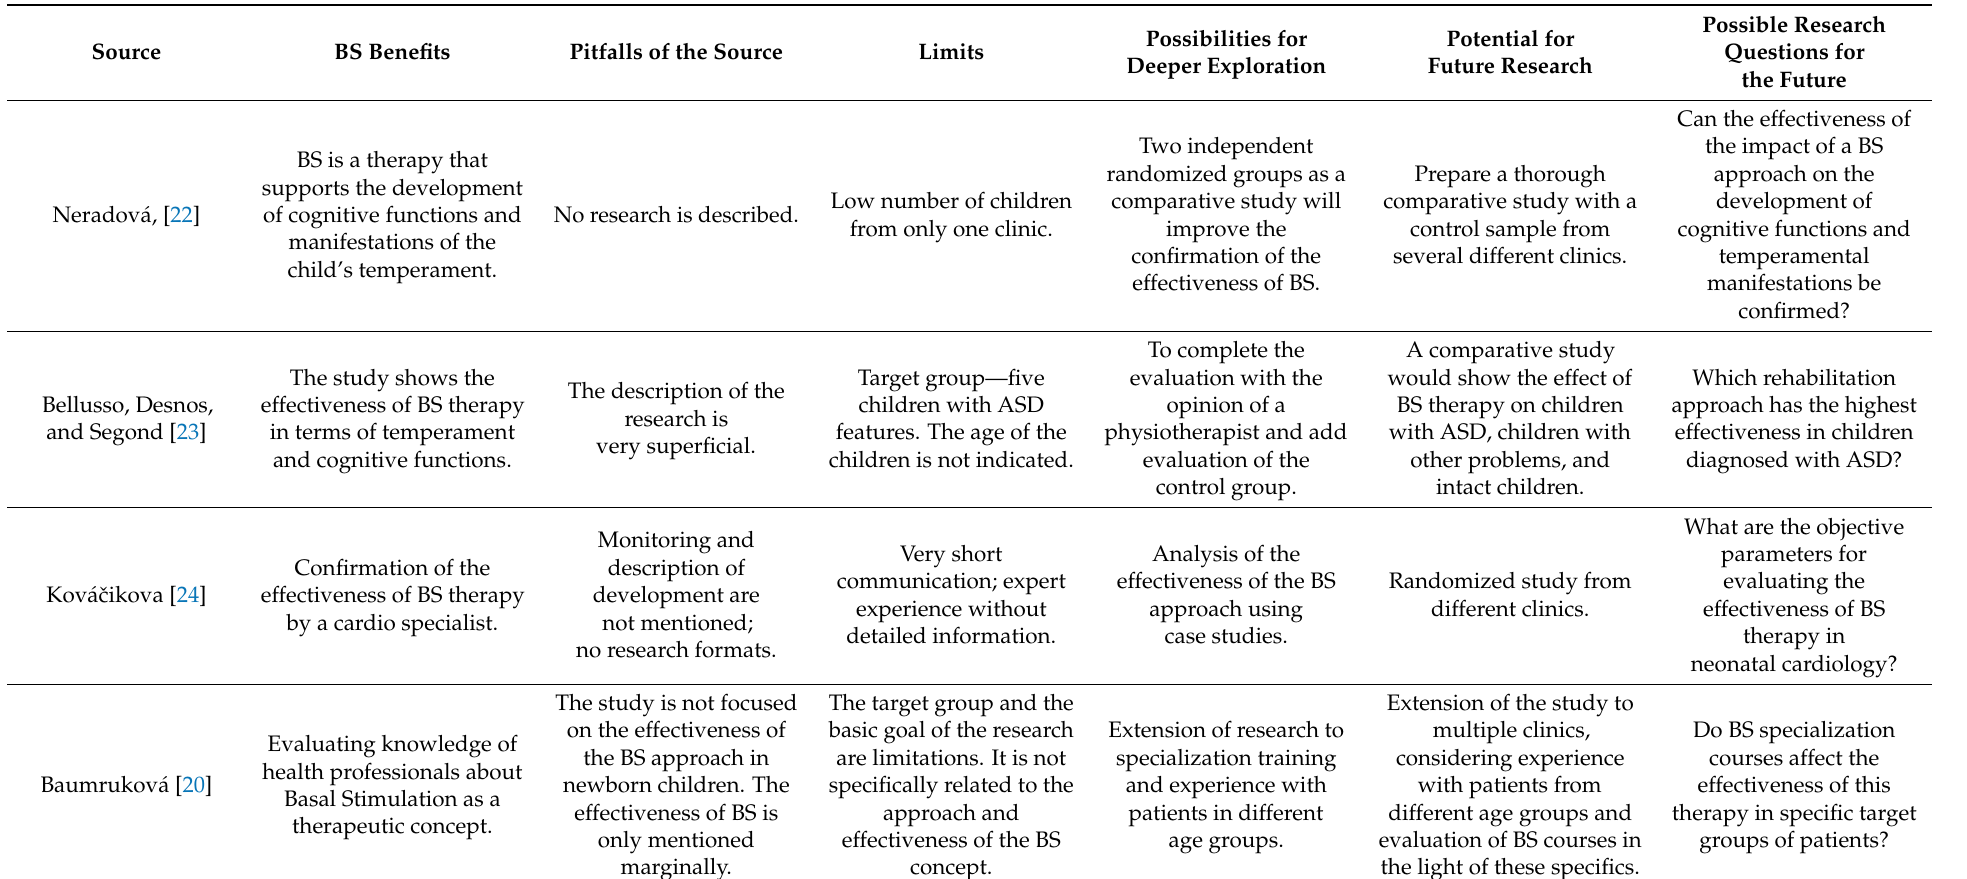
Table 3. Analysis of available literary